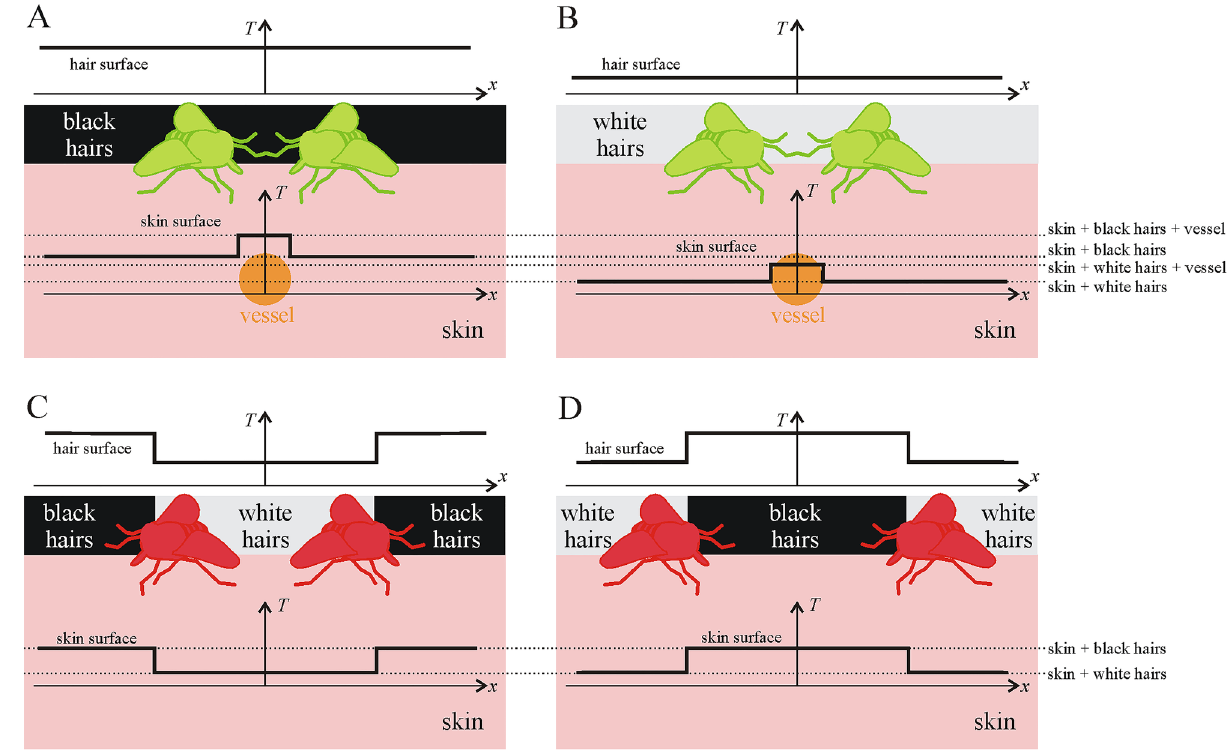
Figure 6. Situations of thermal detection of blood vessels (orange circles) by blood-seeking female horseflies on the sunlit hairy skin of host animals with homogeneous ( A,B ) and striped ( C,D ) pelage patterns. ( A ) Homogeneous black pelage with a vessel next to the skin surface. ( B ) Homogeneous white pelage with a vessel next to the skin surface. ( C,D ) Black and white striped pelage without a vessel in the skin. The inset graphs show qualitatively the spatial change of temperature T of hairs and skin surface along a line x , which crosses the borderlines of neighbouring black and white stripes in panels ( C,D ). The horizontal dotted lines show the four typical T -levels of the skin surface at skin (i) with white hairs < (ii) with white hairs above a vessel < (iii) with black hairs < (iv) with black hairs above a vessel. Green horseflies represent the sites of successful blood- sucking attempts induced by the positive T -gradients (increasing T ) of the skin surface above vessels, while red horseflies represent the sites of unsuccessful blood-sucking attempts induced by the positive T -gradients of the skin surface below the borderlines of black and white hair stripes. The head of horseflies turns toward positive T -gradients. The dimensions of horseflies, vessels and thickness of the hair layer are not necessarily to